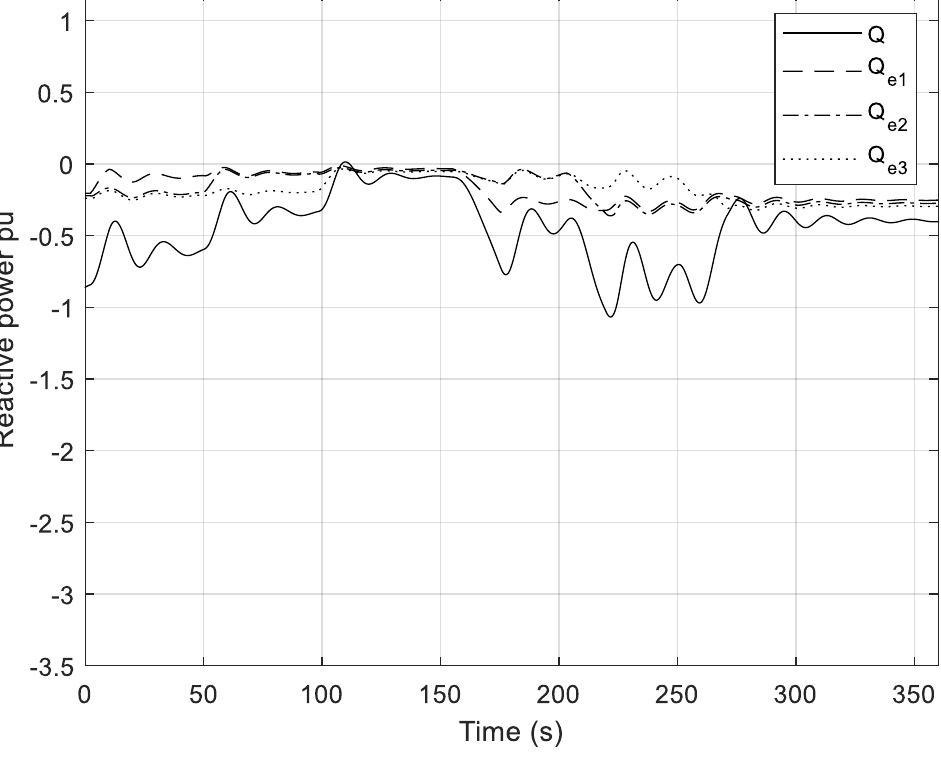
Figure 19. Reactive power of the B2B converter and the reactive powers of PMSGs. Waveforms of B2B converter currents and PMSG currents are shown in Figure 18.